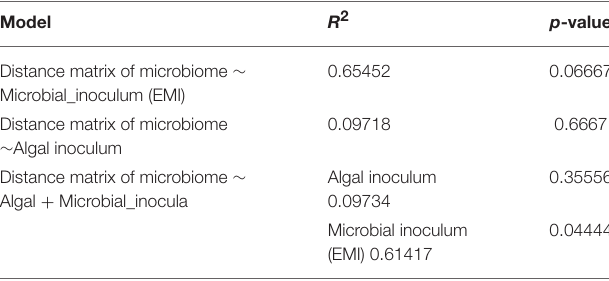
TABLE 3 | Adonis model to test the effects of algal inoculum and microbial inoculum on overall microbial community